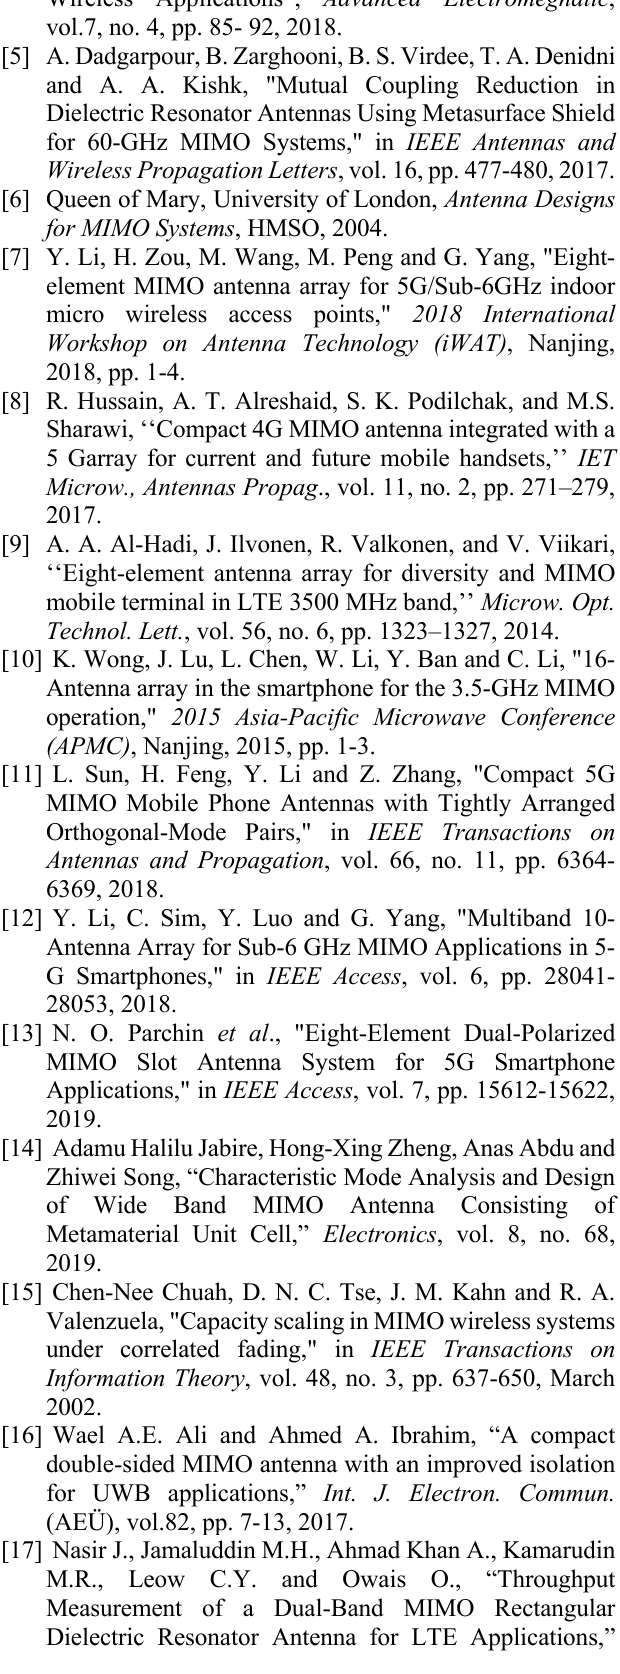
Table 3: Performance comparison of the MIMO